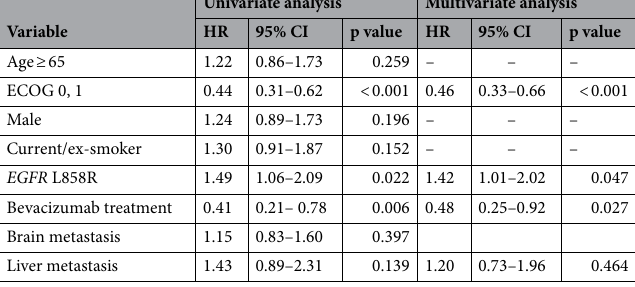
Table 2. Cox regression overall survival